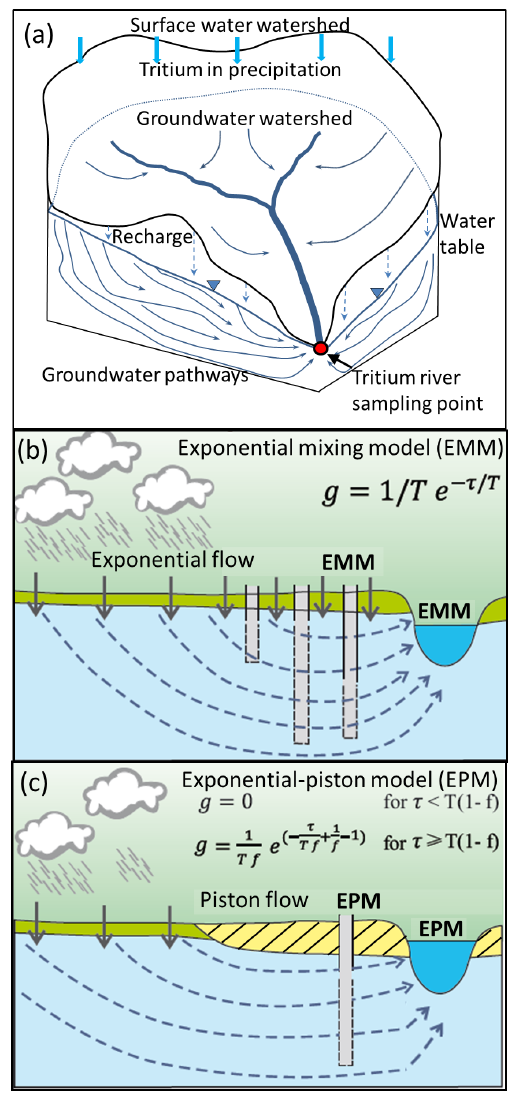
Figure 1. Conceptual diagram of the tritium cycle in a river and sub- surface groundwater storage (a) as the tritium input in precipitation is transformed to the tritium output in river water by passing through the subsurface. These complex dynamics are represented by the ex- ponential mixing model (EMM) for the unconfined aquifer (b) and the EPM for the partially confined aquifer (c)